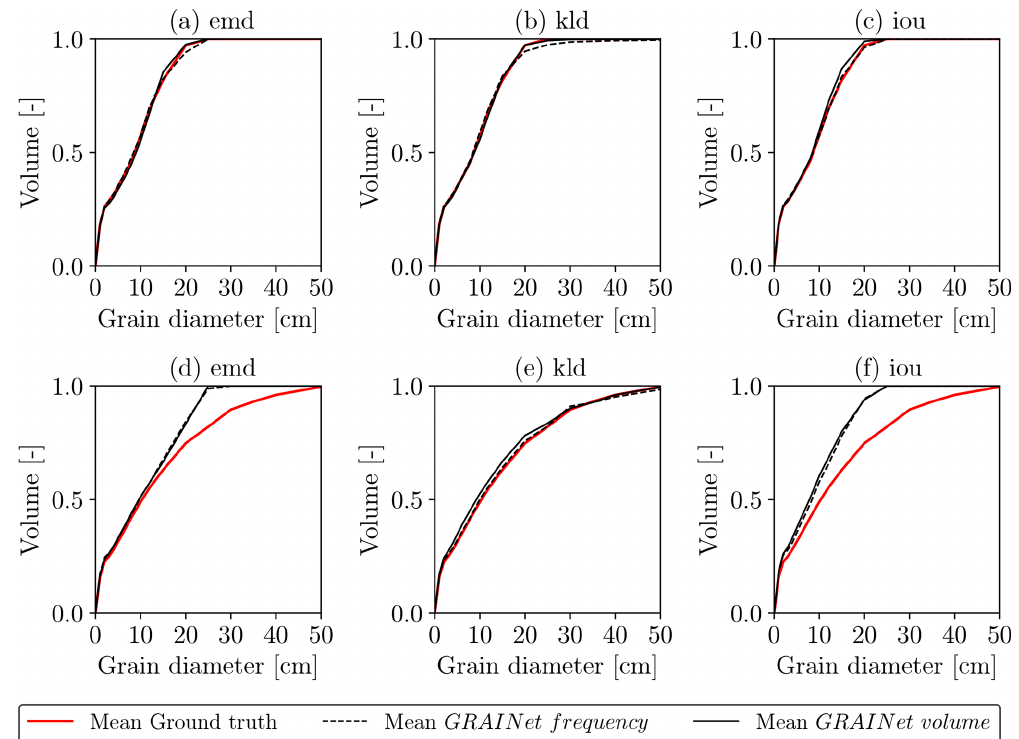
Figure 11. Grading curves resulting from optimizing different loss functions (from left to right: EMD, KLD, IoU) for two example gravel bars, namely, Gr. Entle km 002.0 (a–c) and Reuss km 001.6 (d–f) .